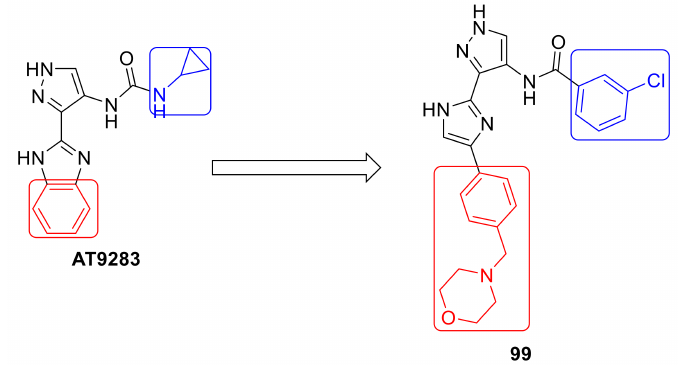
Figure 101. Structures of AT9283 and compound 99